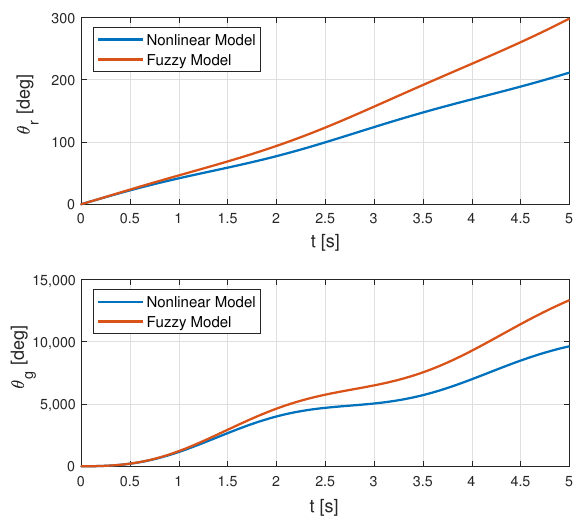
Figure 5. Angular